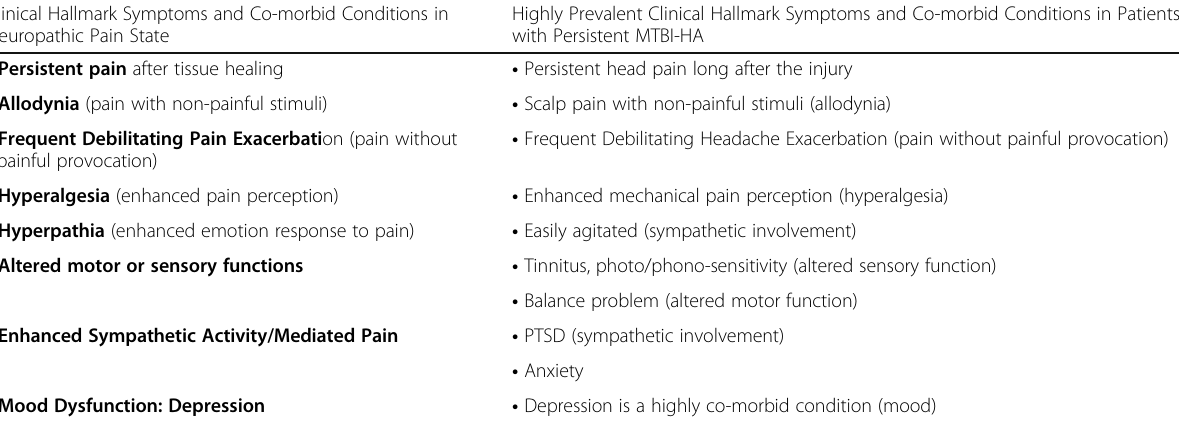
Table 1 Symptom comparisons between neuropathic pain states and persistent mild traumatic brain injury related headaches (MTBI-HA) Clinical Hallmark Symptoms and Co-morbid Conditions in Neuropathic Pain State